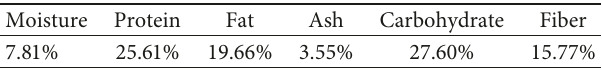
Table 2: Chemical composition of husk tomato powder. Moisture Protein Fat Ash